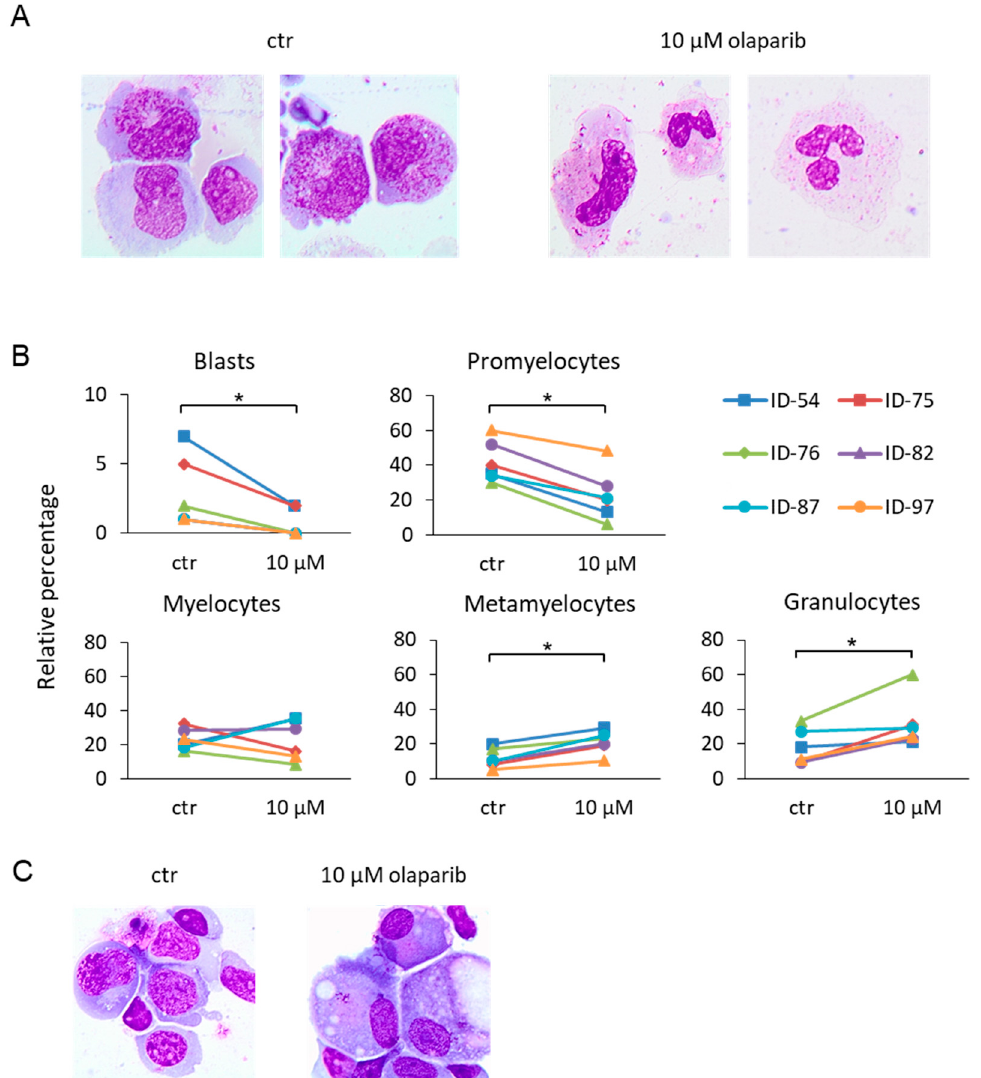
Figure 3. Morphological analysis of MDS samples treated with olaparib. May Grunwald-Giemsa staining of cytospins from six primary MDS samples after 7 days of culture. Untreated cultured cells and those treated with 10 µM olaparib are shown. ( A ) Representative pictures are shown (sample ID-54). Images were taken at 100 × magnification. ( B ) Differential counts using standard microscopy were performed by two specialized hematologists (ADV and MTV). Statistical analysis by paired Wilcoxon test: * p < 0.05. ( C ) Sample ID-79 after 7 days of 10 µM olaparib treatment. Images were taken at 100 × magnification.